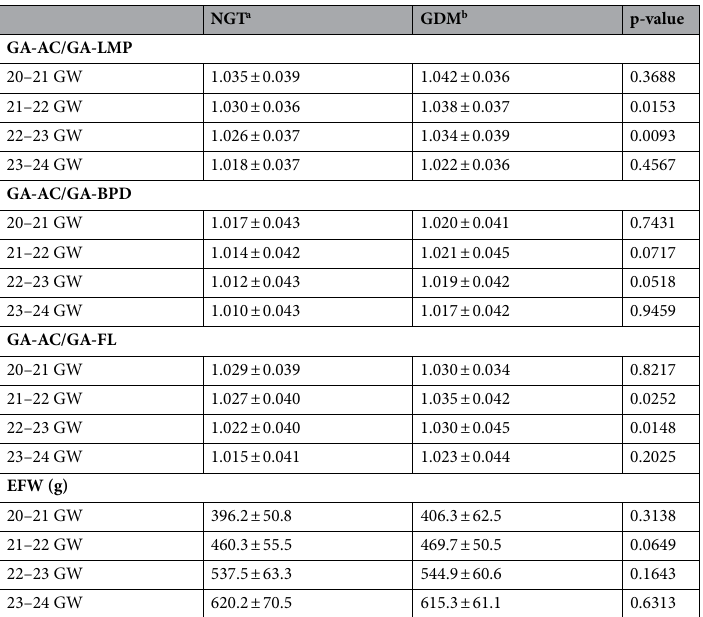
Table 3. FAORs and EFW according to measured GW in the subjects subsequently diagnosed with NGT and GDM. FAOR fetal abdominal overgrowth ratio, EFW estimated fetal weight, NGT normal glucose tolerance, GDM gestational diabetes mellitus, GW gestational week, GA-AC estimated gestational age by abdominal circumference, GA-LMP gestational age by last menstruation period, GA-BPD estimated gestational age by biparietal diameter, GA-FL estimated gestational age by femur length. a Number of NGT subjects having available data for FAORs and EFW at GW 20–21, 21–22, 22–23, and 23–24 were 486, 2344, 2688, and 951, respectively. b Number of GDM subjects having available data for FAORs and EFW at GW 20–21, 21–22, 22–23, and 23–24 were 28, 124, 148, and 48, respectively.